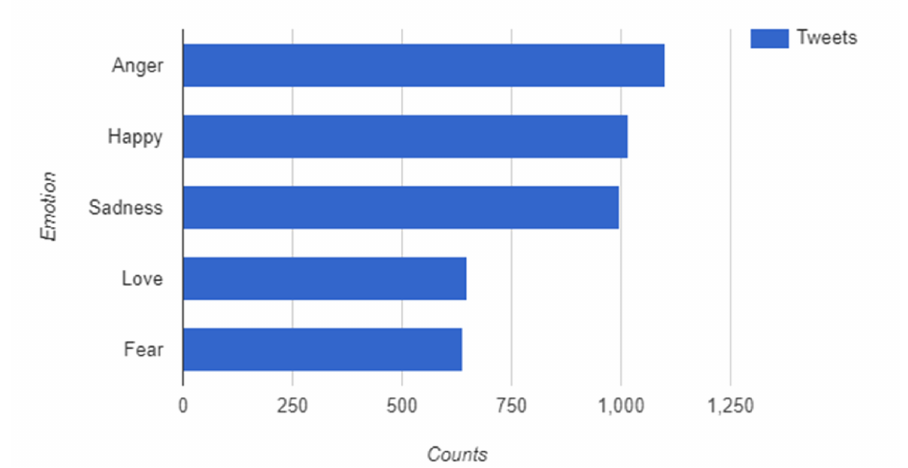
Fig. 2. The tweets distribution by the emotion in the dataset shows an